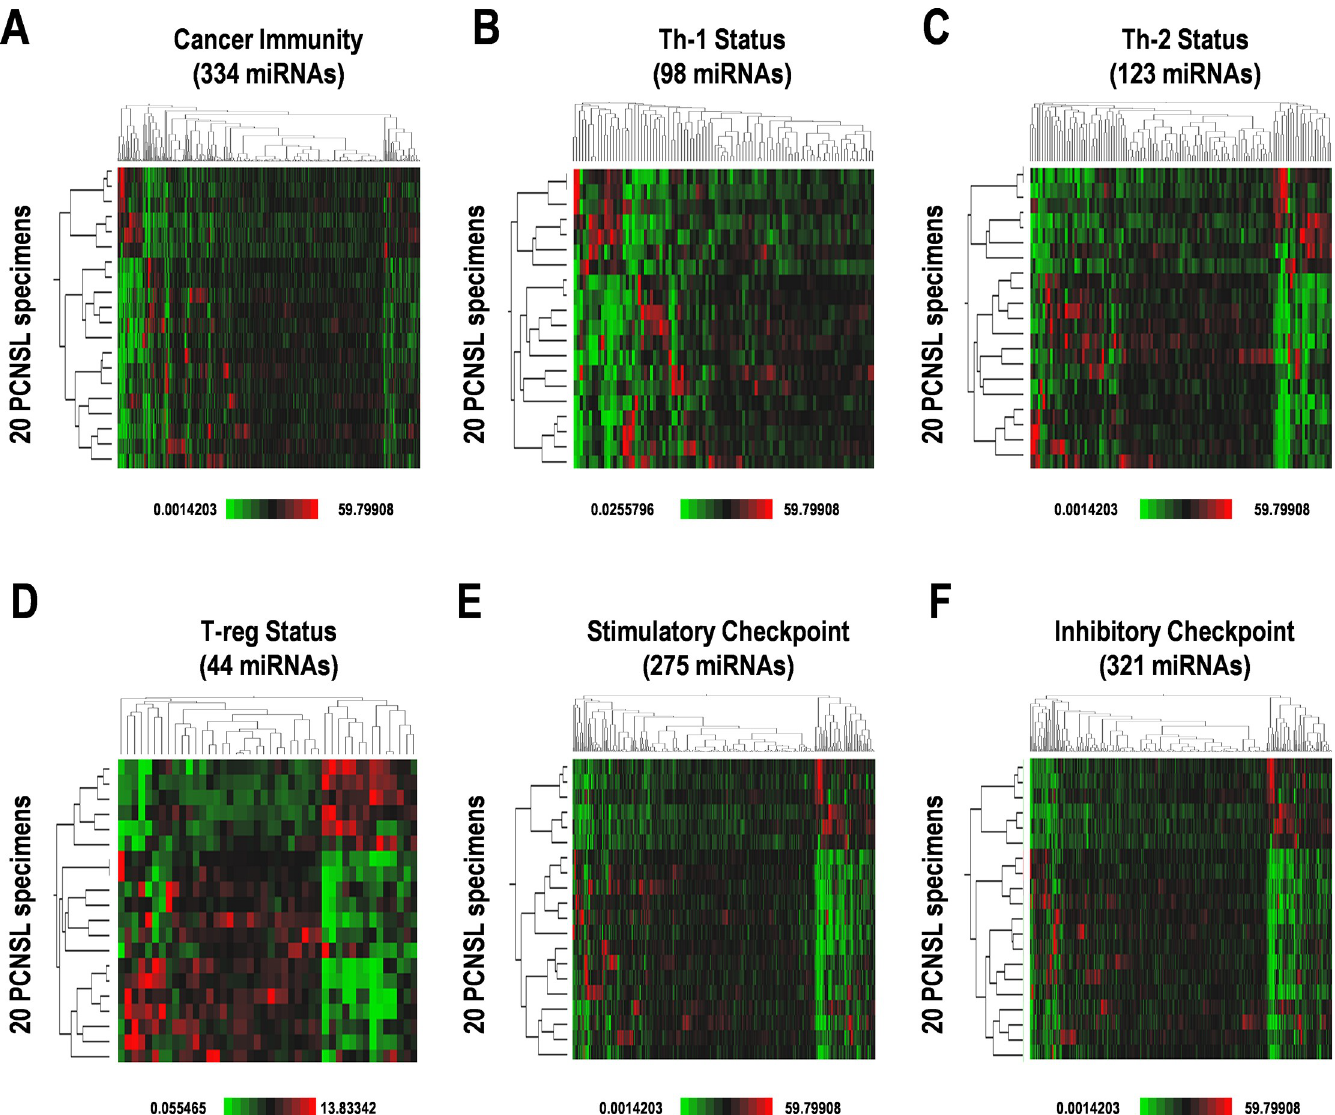
Fig 1. Differential expression of cancer immunity-related miRNAs in PCNSL patients. Hierarchical clustering of expression of miRNAs involved in ( A ) cancer immunity; and subgroups including ( B ) Th-1 status, ( C ) Th-2 status, ( D ) regulatory T-cell (T-reg) status, ( E ) stimulatory checkpoint, and ( F ) inhibitory checkpoint. Relatively high and low expression, designated as higher expression and lower expression by median expression, are indicated by red and green, respectively.